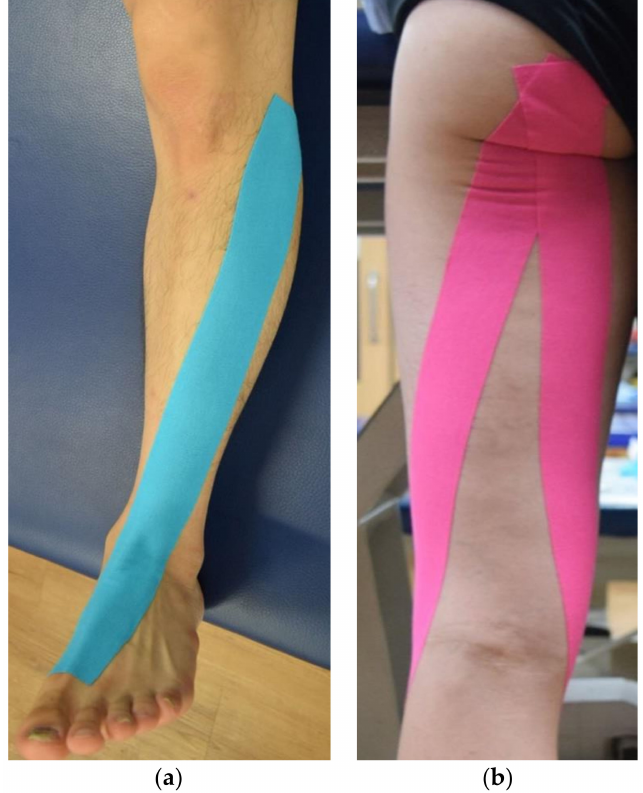
Figure 2. Application of kinesiology tape to the tibialis anterior muscle ( a ), hamstring muscles ( b